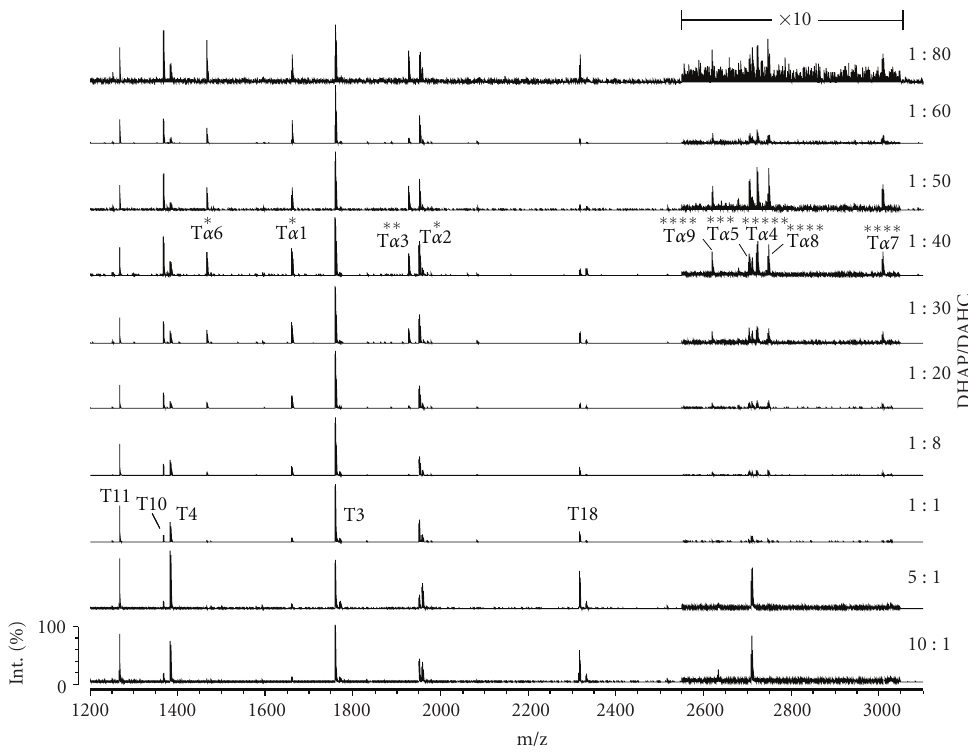
Figure 1: The MALDI mass spectra of the tryptic digest of α -casein (250fmol on target) measured in positive ion mode with DHAP/DAHC matrix at di ff erent ratios (10:1 to 1:80). The signal intensity is magnified 10-fold in the m/z range from 2575 to 3025. The number of sites on each phosphopeptide is equal to the number of asterisks ( ∗ )